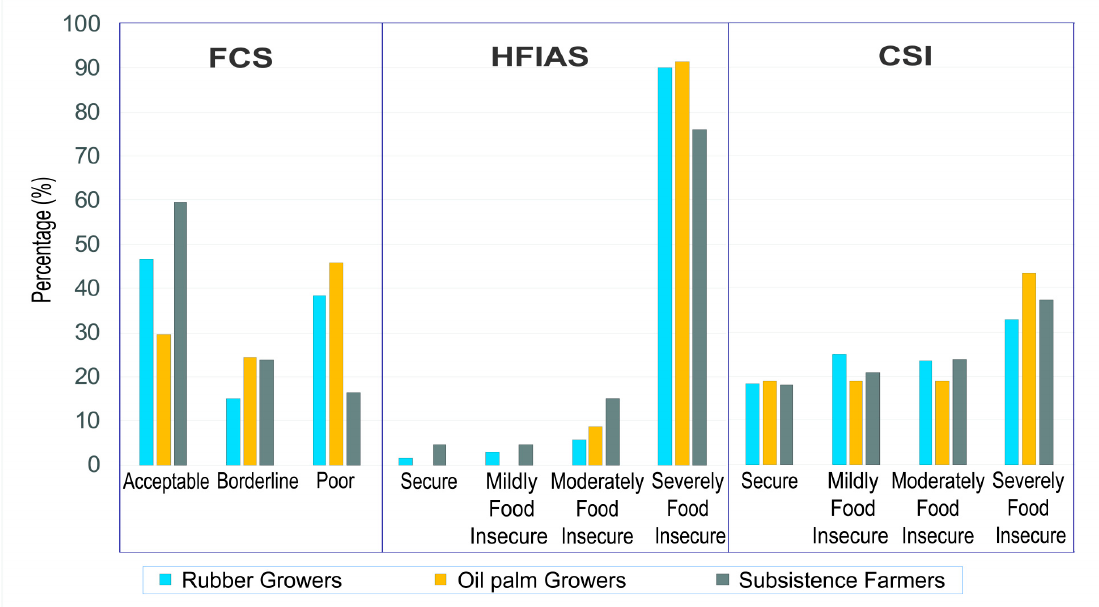
Figure 2. Respondent distribution across food security thresholds for the different metrics.